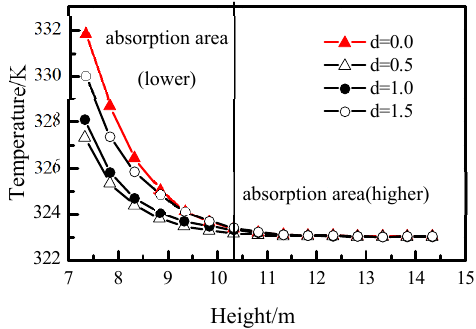
Figure 9. Average temperature in representative section.